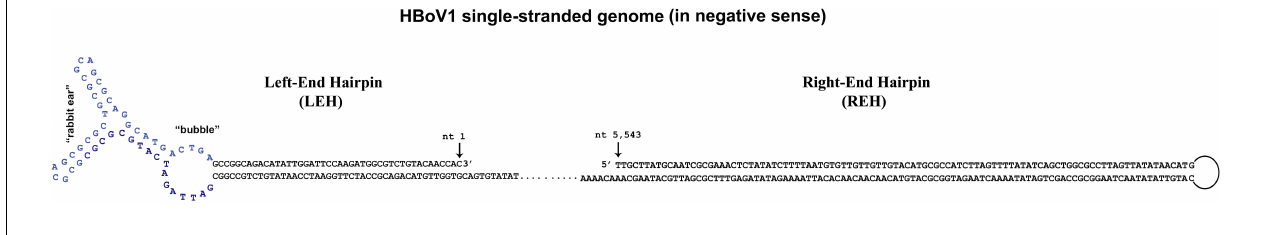
FIGURE 1 | Sequence and structure of the HBoV1 left and right end hairpins. The structures of HBoV1 LEH and REH are shown with the 3 (cid:48) end and 5 (cid:48) end sequences, respectively, which were predicted using the DNAMAN program (Lynnon, Co., Quebec, Canada). The ear and bubble are indicated, as well as the start and end nucleotides of HBoV1 genome. The sequence refers the full-length HBoV1 genome of the isolate Salvador1 (GenBank accession no.: